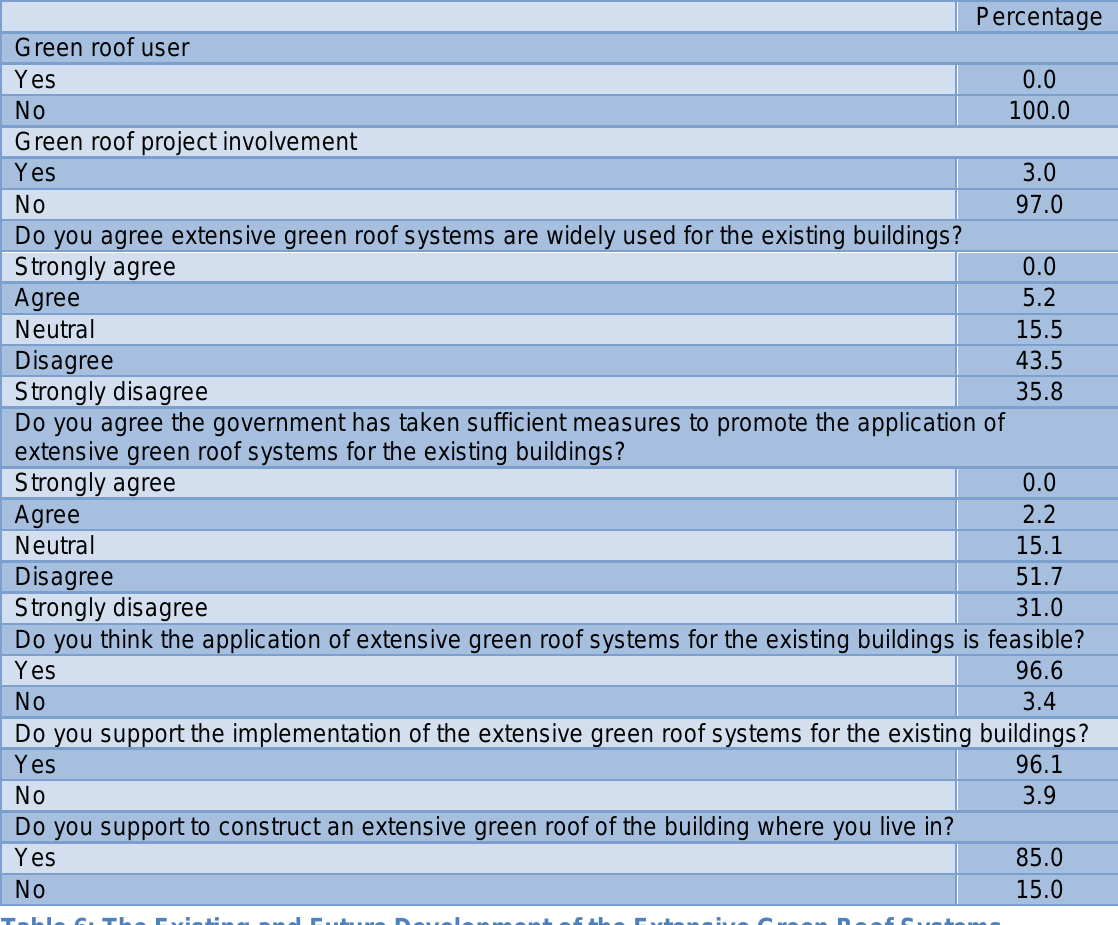
Table 6: The Existing and Future Development of the Extensive Green Roof